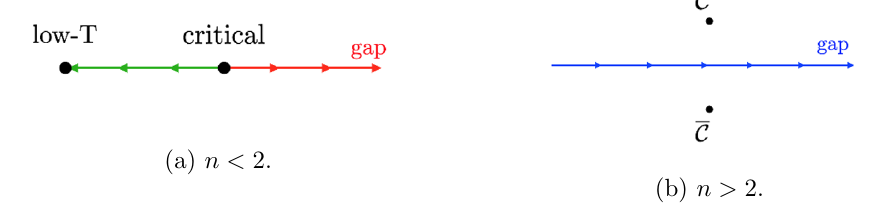
Figure 5. RG (cid:13)ows triggered by deformation of O ( n ) CFTs by " . Green | positive coupling, (cid:13)ow studied in section 6; red | negative coupling, (cid:13)ow studied in [82]; blue | complex coupling deformation of an n > 2 complex